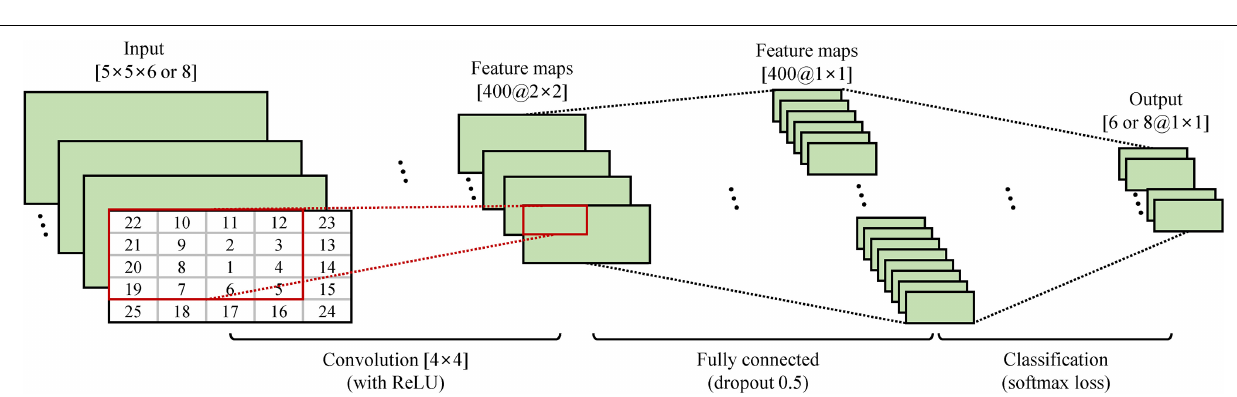
FIGURE 3 | Experimental environments with SHAP protocol. (A) Environments for SHAP protocol. (B) Grip types for SHAP with light objects. (C) Grip types for SHAP with heavy objects.